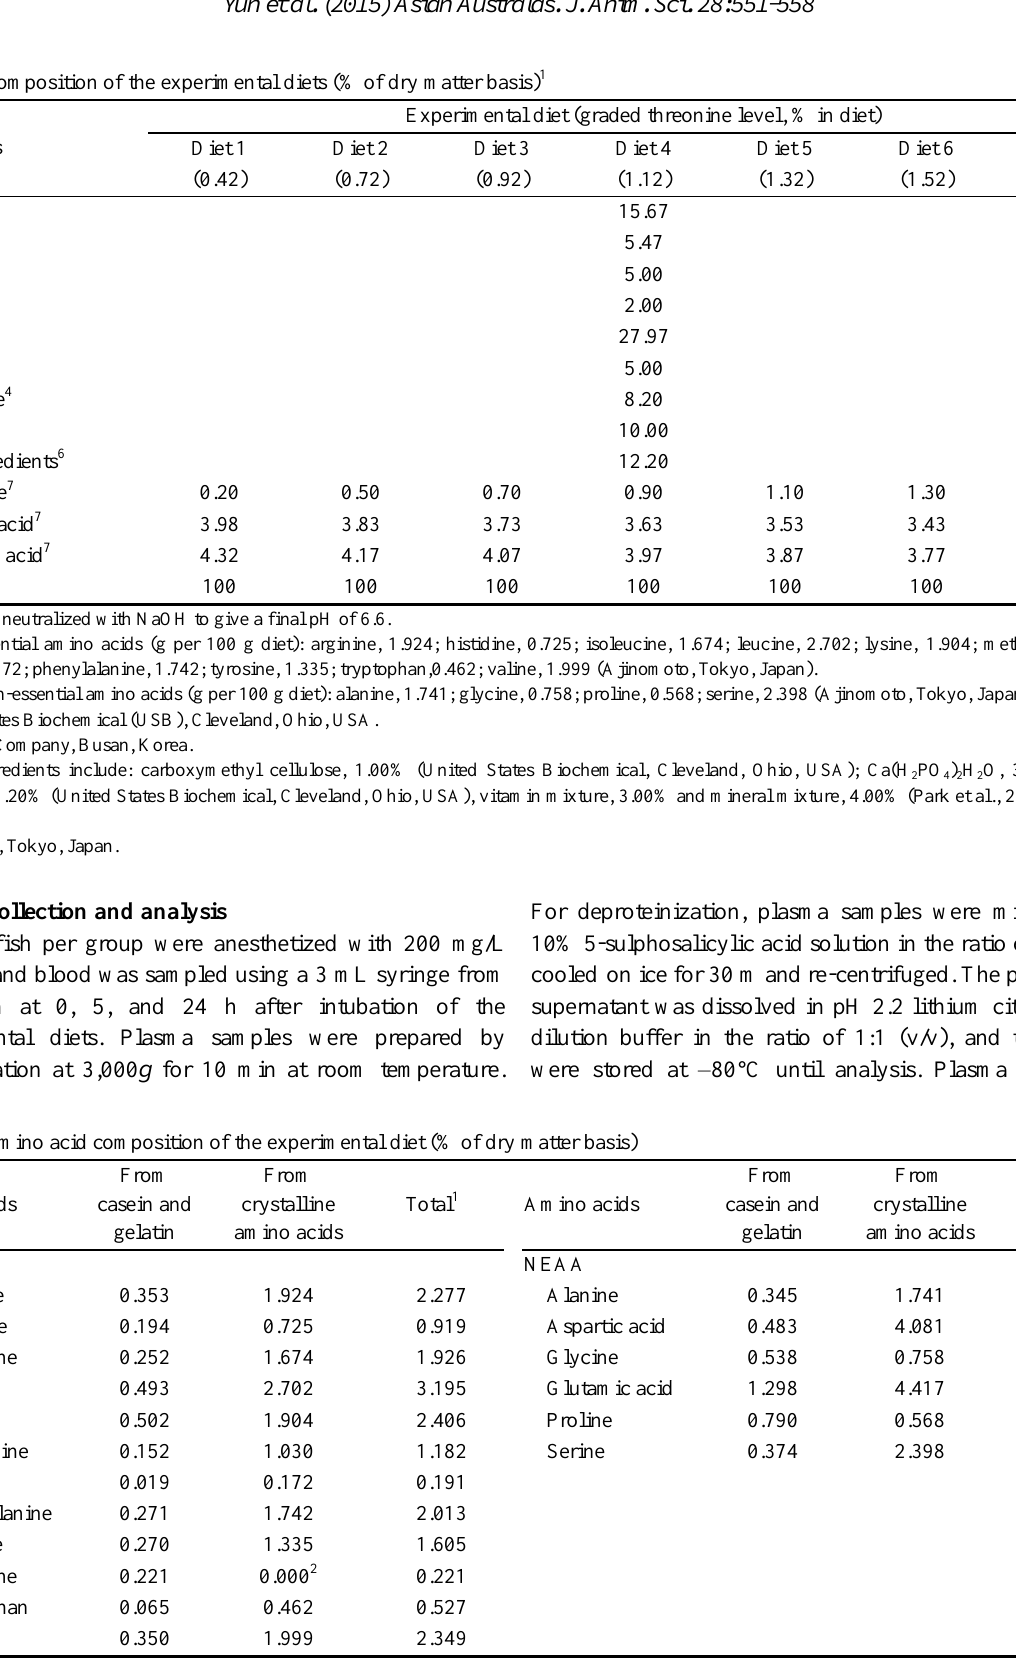
Table 1. Composition of the experimental diets (% of dry matter basis) 1